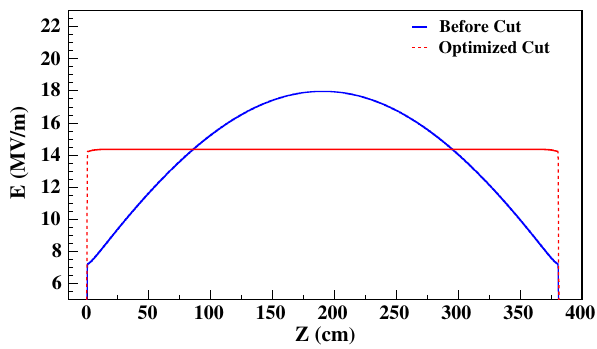
FIG. 4. Intervane field along the RFQ before and after applying the appropriate vane undercuts.